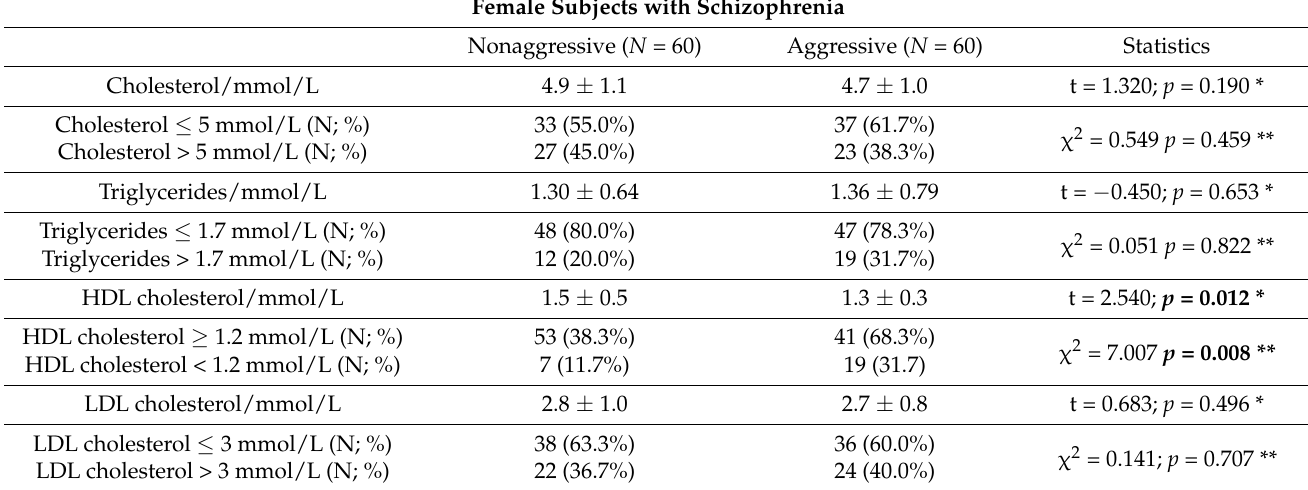
Table 2. Lipid concentrations in subjects with schizophrenia depending on the presence of aggres- sive behavior.